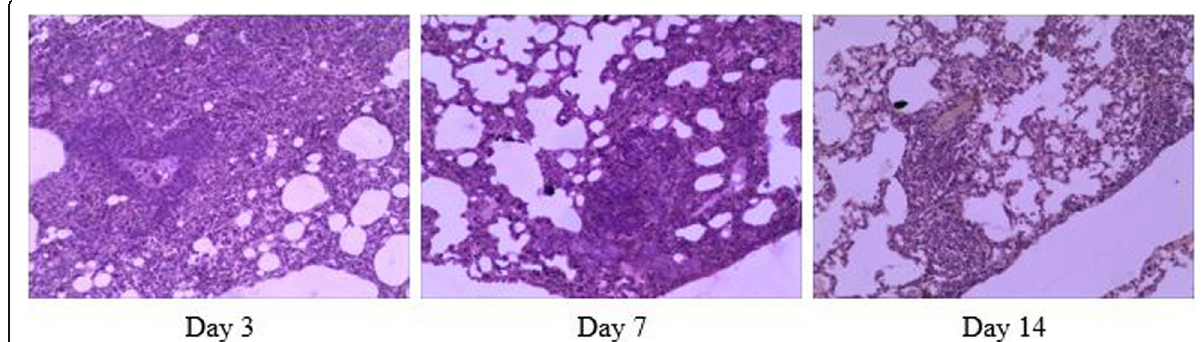
Fig. 5 Lung histopathological observation of Ciprofloxacin treated group